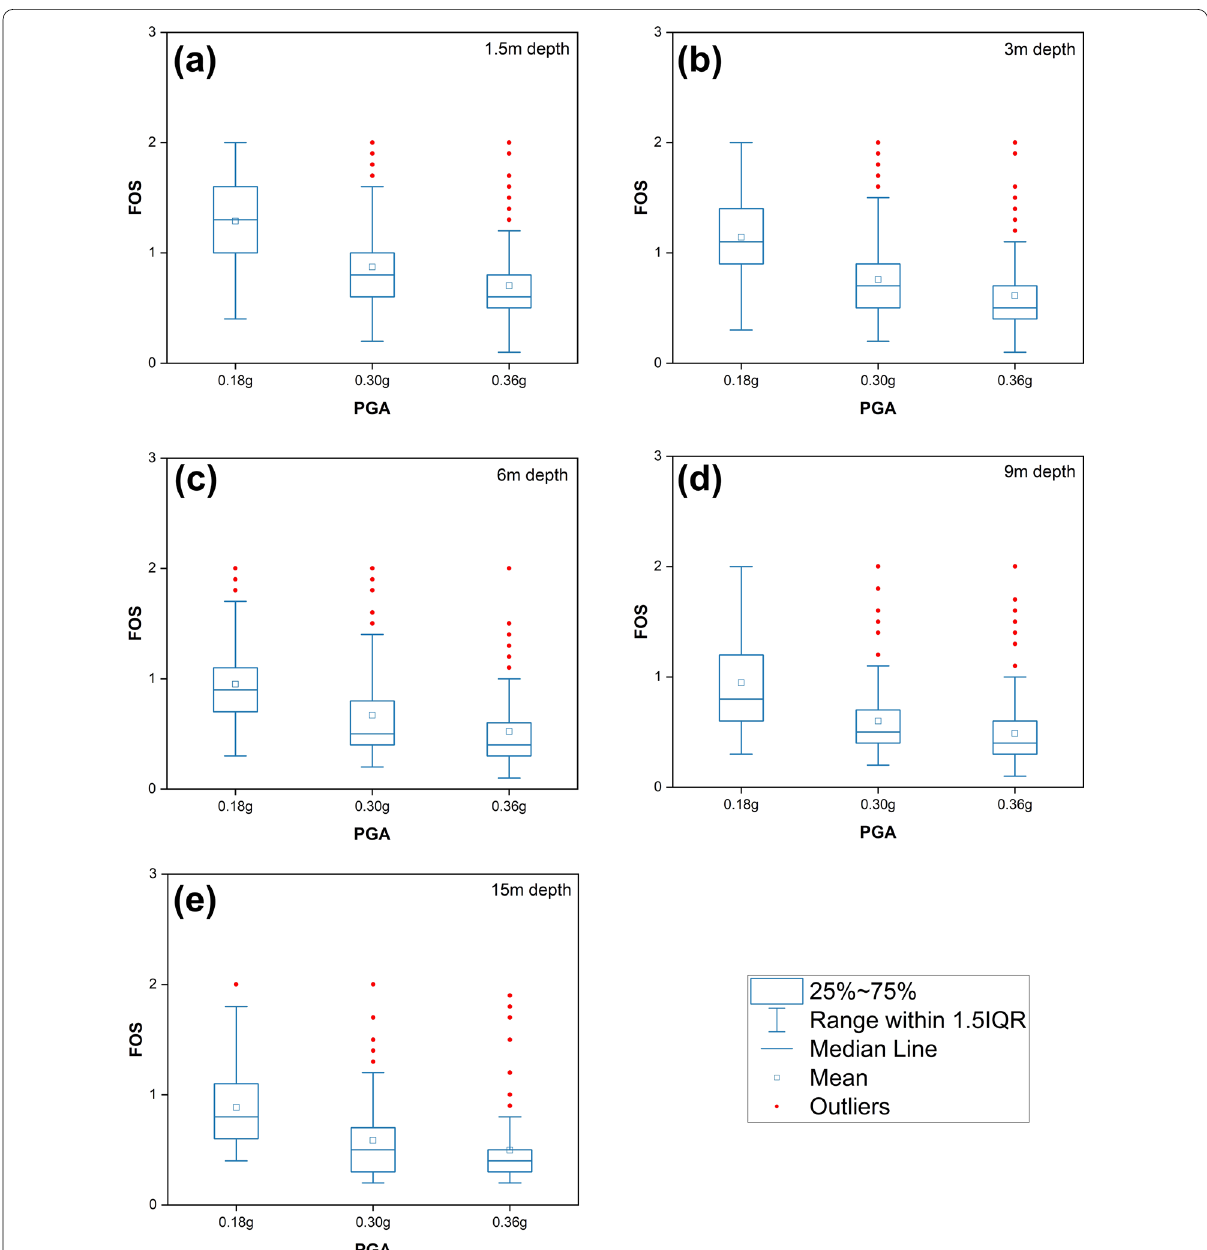
Fig. 7 Box plots of the factor of safety (FOS) against liquefaction for three PGAs at depths of a 1.5 b 3 c 6 d 9 and e 15 m in the Kathmandu Valley where (N 1 ) 60 is the SPT-N normalised to an overburden pressure of 101 kPa (i.e., atmospheric pressure) with a hammer efficiency of 60%. N is the measured SPT blow count. C N is the correction factor for overburden stress. C B is the correction factor for borehole diameter. C E is the correction factor for the hammer energy ratio. C R is